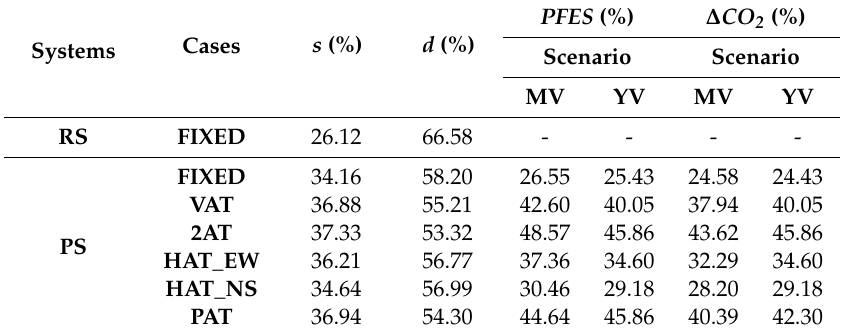
Table 6. Energy and environmental analysis results on annual basis for PS and RS in both scenarios. Systems